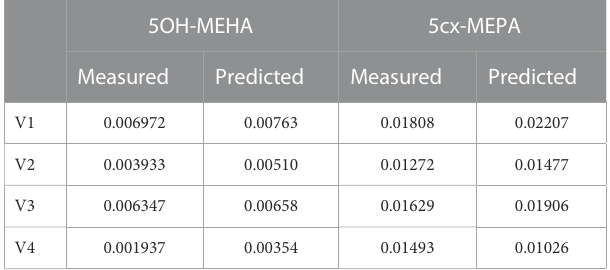
TABLE 6 Comparisons of predictions and measured 48-h eliminations of 5OH- MEHA and 5cx-MEPA for the four volunteers under the posterior mode parameter